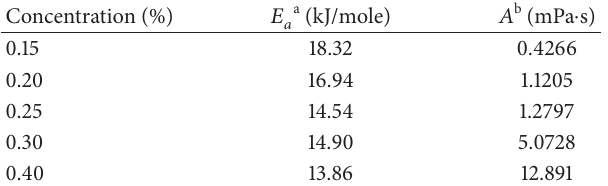
Table 2: Activation energy and pre-exponential factors obtained from Arrhenius-type relation for different polymer